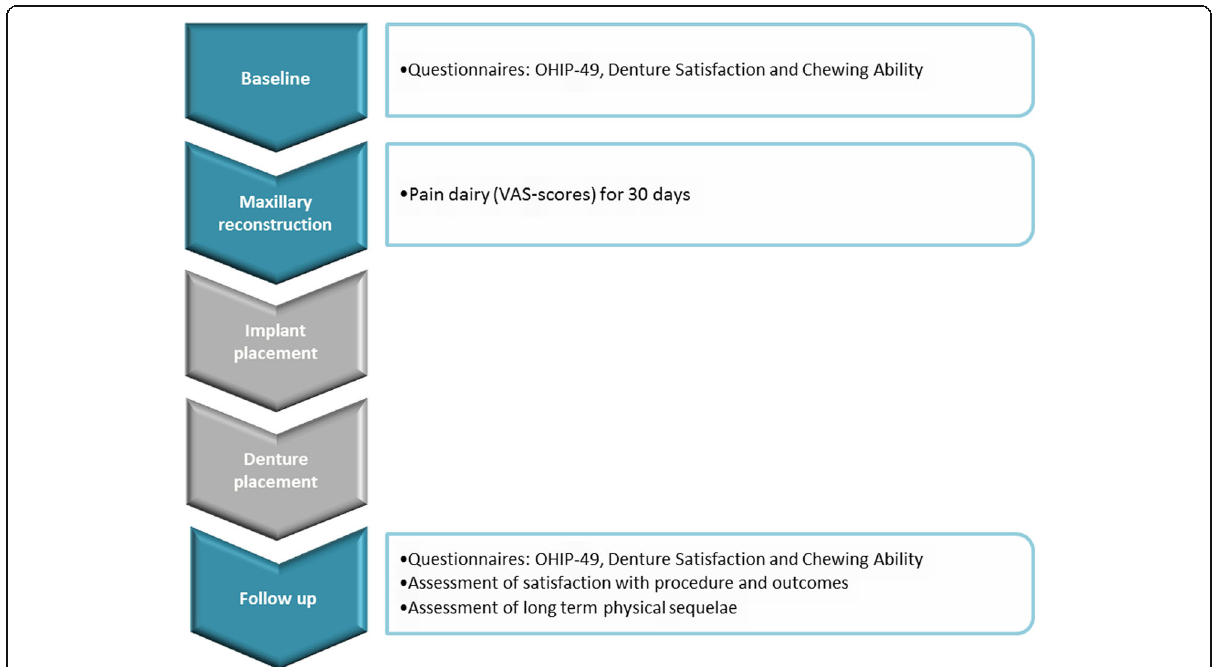
Fig. 1 Timing of PROM assessments in treatment programme. The PROMS were assessed at pre-defined steps in the treatment programme of an individual participant. First, when a participant was included for the study but before an intervention had taken place, the OHIP-49NL, denture satisfaction and chewing ability questionnaires were administered to determine the baseline level of oral health-related quality of life, satisfaction with the current denture and perceived ability to chew food, respectively. Next, directly following the reconstruction surgery that included the bone graft harvesting from either calvarium or anterior iliac crest, the post-operative pain was assessed by asking participants to report the perceived pain at donor site on a 100-mm VAS score for 30days. Following a 4-month osseointegration phase, the implants were placed in the reconstructed maxilla. Another 4 months later, the patients received their implant-retained denture. No PROMs were assessed during these two steps as they were not related to the bone graft harvesting surgery. Finally, at a 12-month follow-up meeting, the OHIP-49NL, denture satisfaction and chewing ability questionnaires were administered again to measure improvement or decrease in scores. Moreover, patient satisfaction with the procedure and the outcomes were assessed as well as presence of long-term physical sequelae resulting from the bone graft harvesting